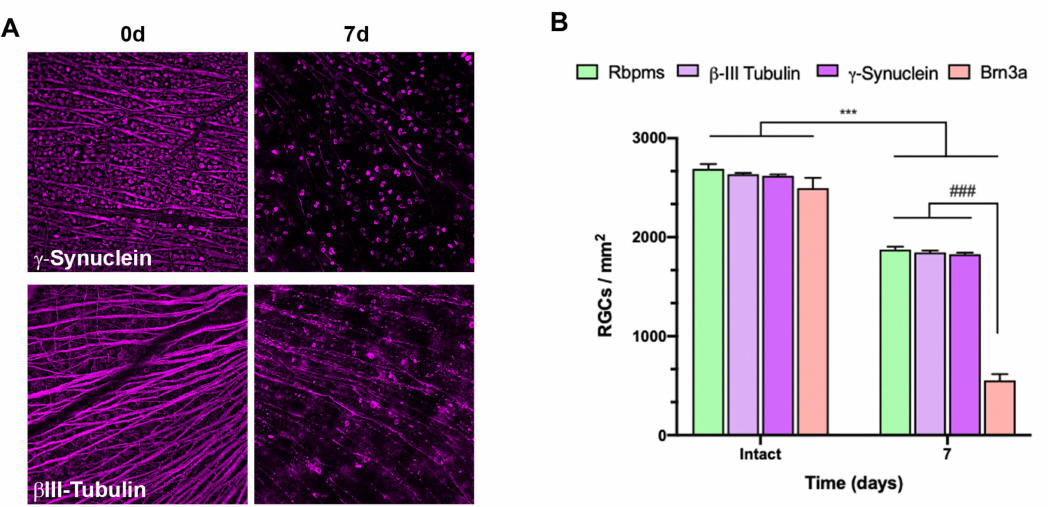
Figure 3. Structural RGC markers are immunodetected in ROCs after RGC death. ( A ) Representative magnifications from intact retinas and ROCs at day 7 showing γ -synuclein and β -III tubulin immun- odetection ( B ) Bar graphs showing the mean ± SD density (cells/mm 2 ) of RGCs immunodetected with each marker in intact retinas, and in ROCs after 7 days (images for Rbpms and Brn3a are shown in Figure 2). Intact vs. 7d (*** p < 0.001, Mann–Whitney test); Significant difference between markers at 7 days (### p < 0.001, Kruskal–Wallis, Dunn’s multiple comparisons test). n = 4–6